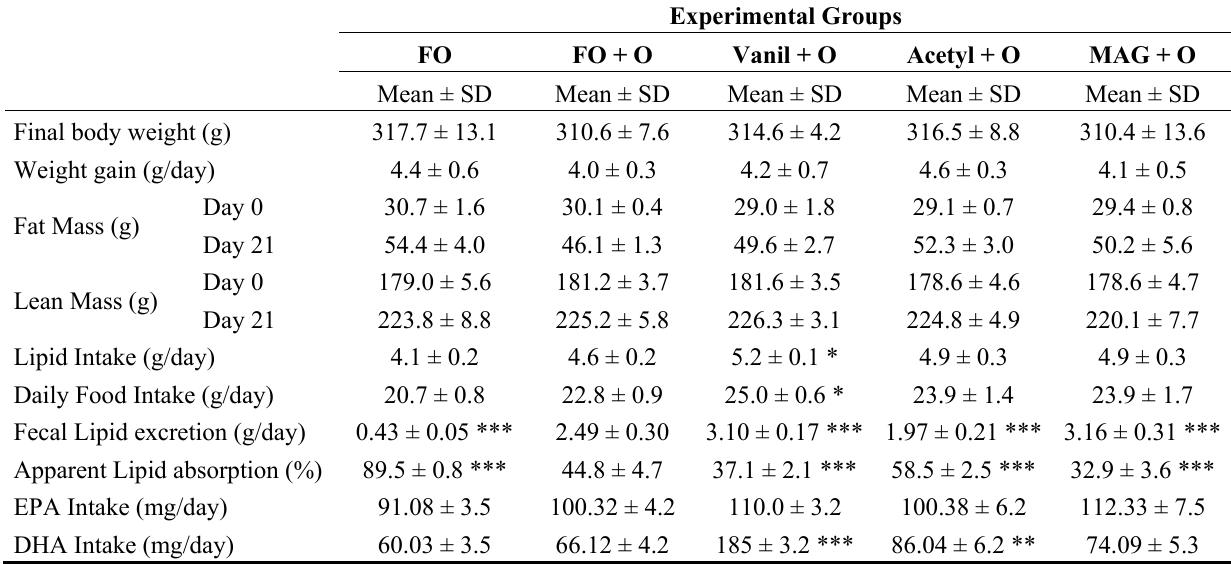
Table 2. Weight Parameters, Dietary Intake and Apparent Lipid Absorption in rats fed different oils for 21